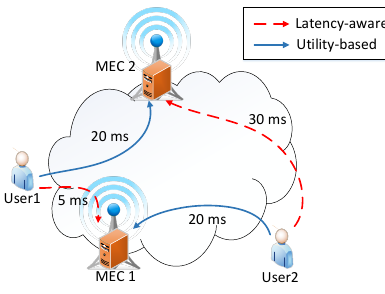
Figure 3. Illustrative